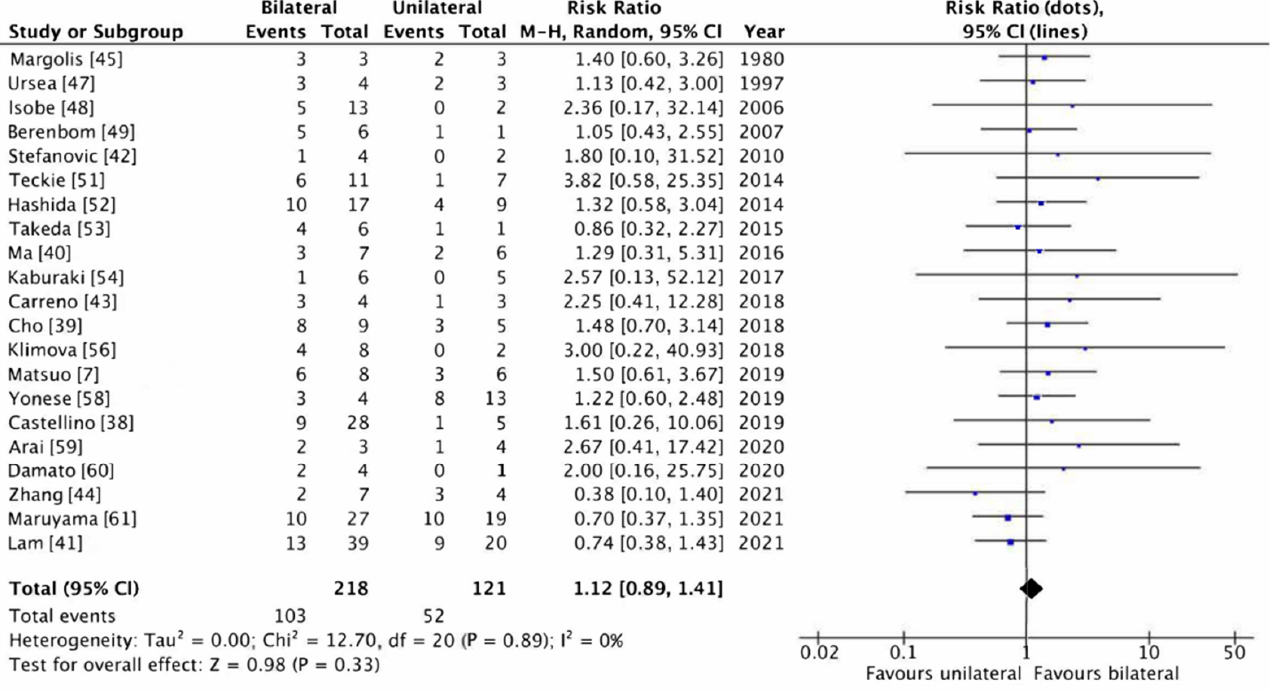
Figure 2. Forest plot of relative risk of CNS progression for PVRL with bilateral involvement compared to unilateral involvement.